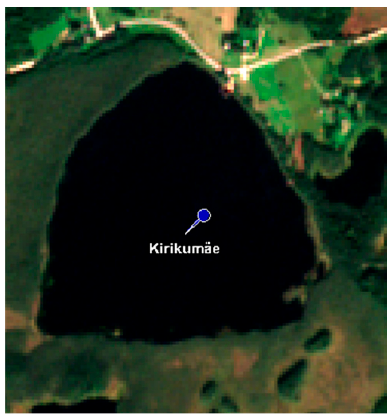
Figure A4. S2 MSI image of Kirikumäe from 30th of August 2017.